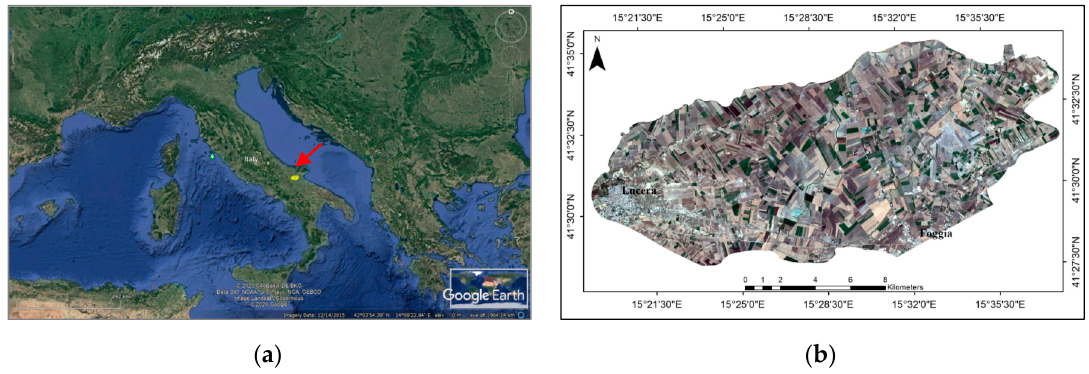
Figure 1. Study area location: ( a ) Italy by Google Earth Pro image; ( b ) Study area by Sentinel-2A August 2019 (RGB 4,3,2).